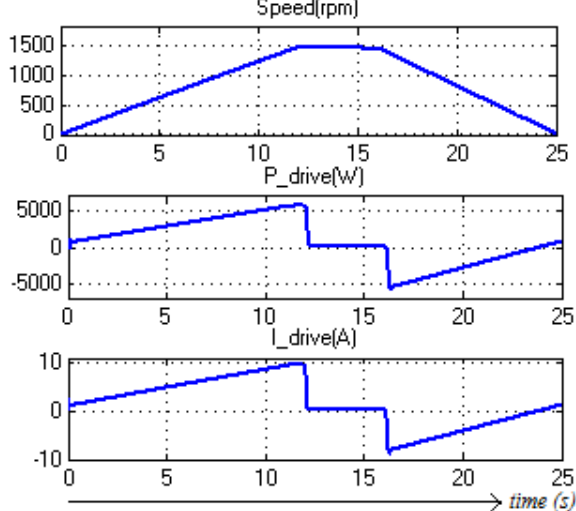
Fig. 5. Simulation diagrams of traction